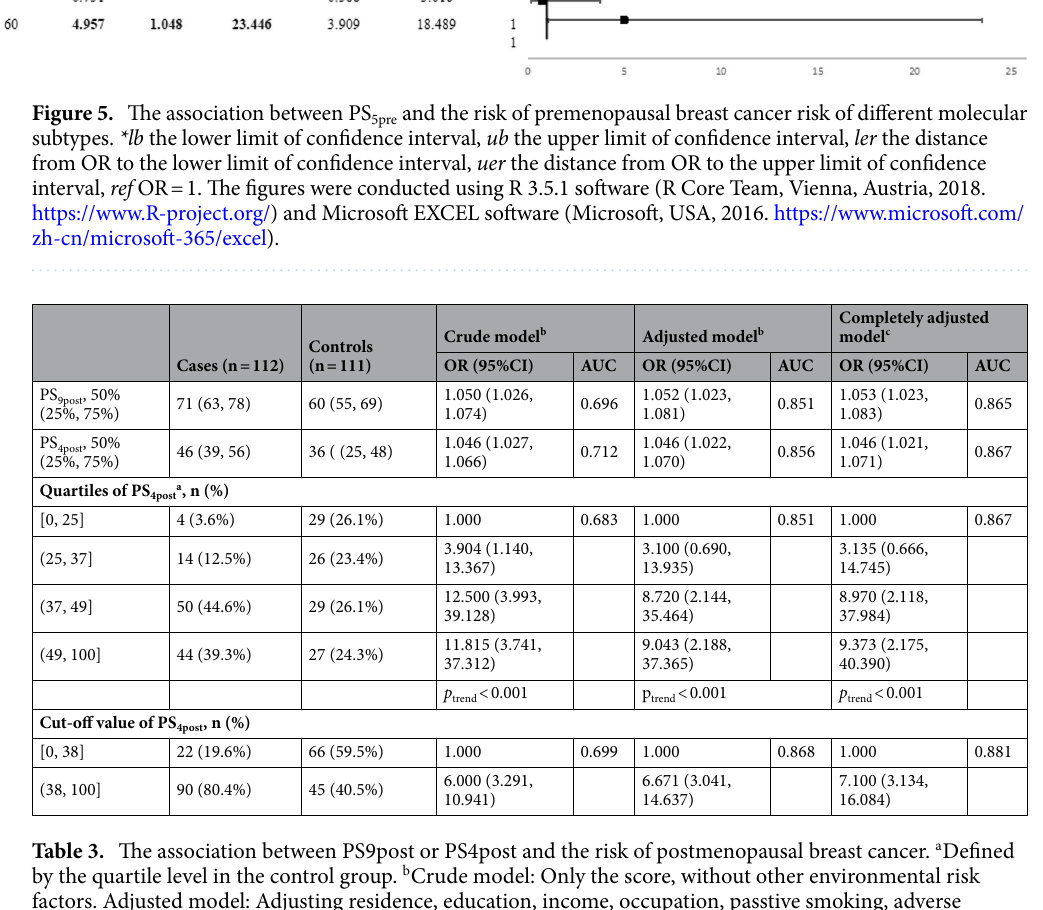
studies have suggested that chronic inflammation often coexists in tissues that are affected by malignant tumors. Besides, cancer cells could aggravate chronic inflammation response and impart tumor micro-environment,